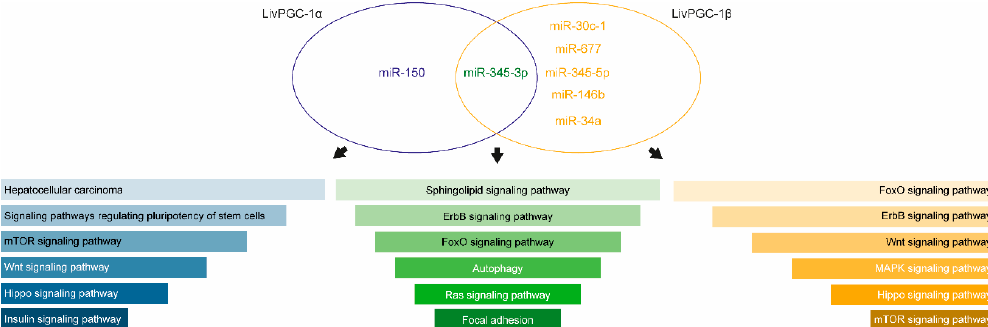
Figure 4. MicroRNA target prediction and enrichment analysis of the predicted target genes. The selective overexpression of PGC-1 α or PGC-1 β in the mice liver lead to the upregulation of different microRNAs. Genes targeted by differentially expressed miRNAs were predicted using TargetScan database. The gene set enrichment analysis was performed using EnrichR. The bar graphs display the predicted mouse Kyoto Encyclopedia of Genes and Genomes (KEGG) pathways based on p-value ranking.